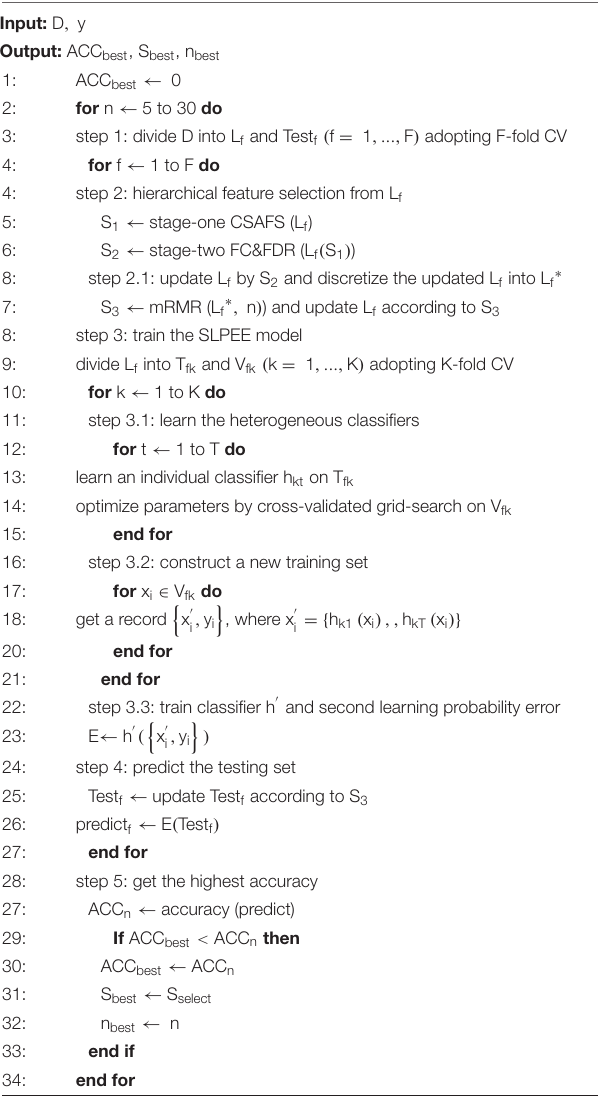
Algorithm 1: The SLPEE based on F-fold